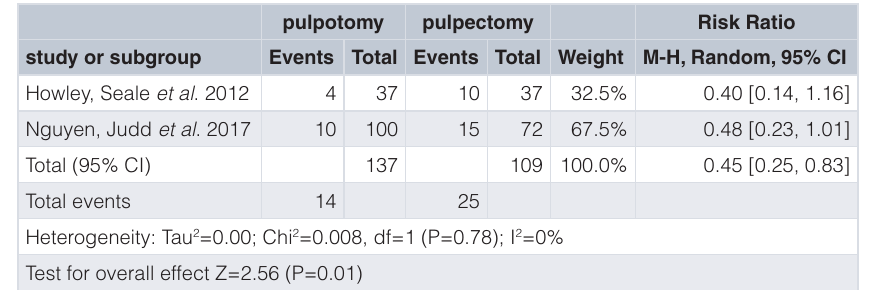
Table 8. Sensitivity analysis for radiographic